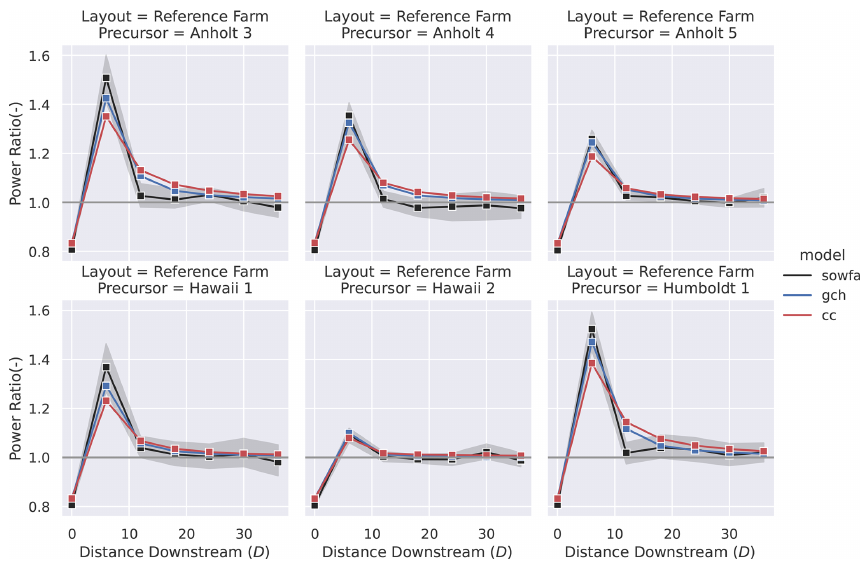
Figure 6. Comparing the ratio of the average power produced per wind turbine row (indicated by the point, shading indicating confidence interval) for the Reference Farm type across precursors when the front row of turbines is changed from aligned to a yaw of + 25 ◦ (counter-